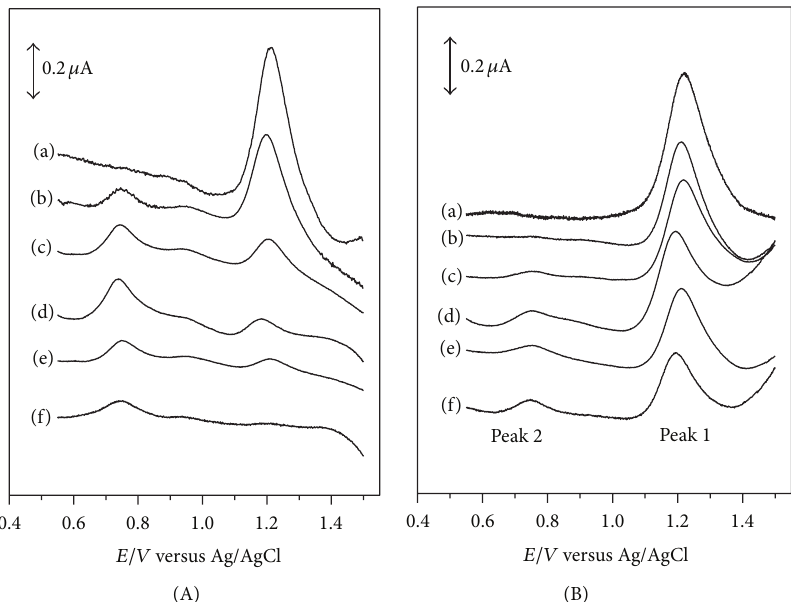
Figure 2: Square wave voltammograms obtained for the photodegradation of 0.5 mM solutions of MCPA in the (A) absence and (B) presence of 35mM concentration of HP- 𝛽 -CD after (a) 0, (b) 25, (c) 50, (d) 65, (e) 75, and (f) 130 hours of irradiation in pH 4 acetate buffer electrolyte. Scan rate: 50mVs −1 .